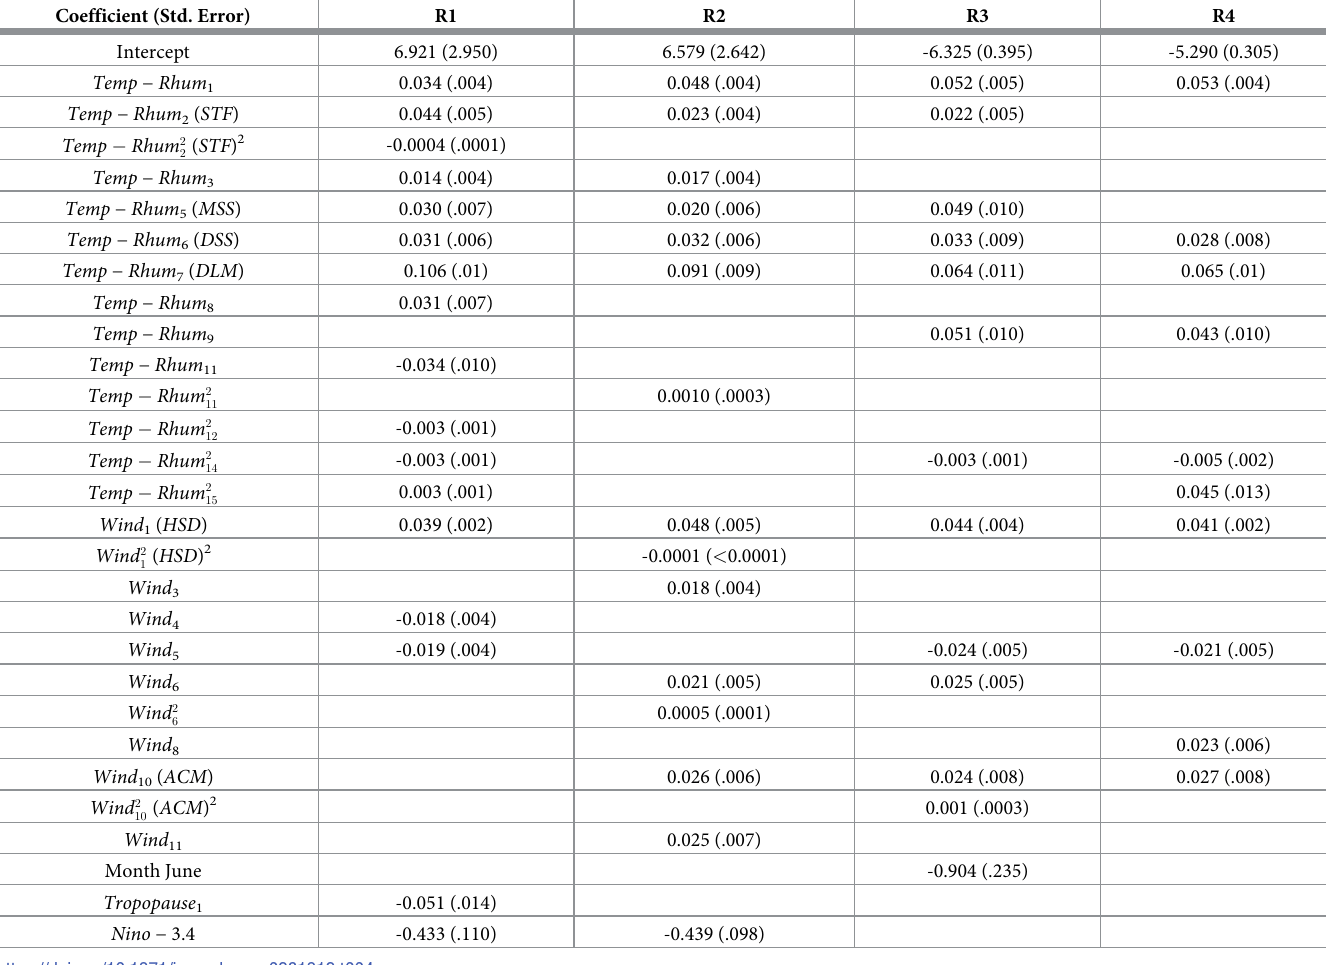
Table 4. Summary of the fitted logistic regression models estimating probability of occurrence of a significant tornado (EF2-EF5) in each of the four regions. For each region, the table has only the estimates of the significant predictors and their corresponding standard error ( Std. Error ). Coefficient (Std.